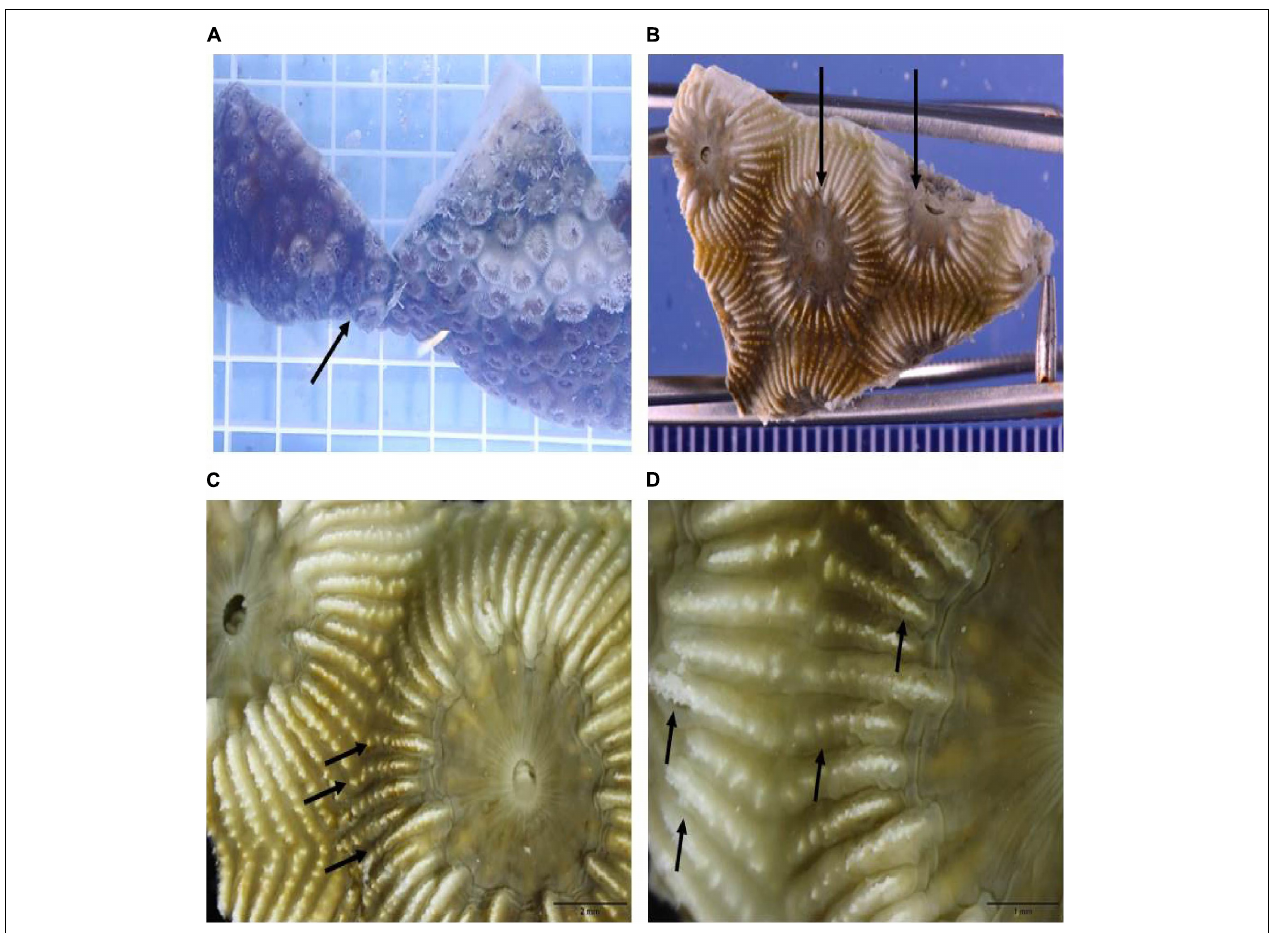
FIGURE 5 | Gross appearance of tissue loss lesions induced after 2 days by direct contact of a M. cavernosa recipient fragment exposed to a D1 fragment. (A) In situ view of lesioned recipient fragment in direct contact showing appearance of gross lesions (arrow) adjacent to the lesion border on the donor fragment. (B) Excised recipient fragment taken for histology showing higher magnification tissue loss area at black arrows. (C) Macroscopic view of two polyps showing the initiation areas of tissue loss on individual septa and separation of the tissue away from the skeleton (on each septal ridge) at black arrows. Note tissue loss on